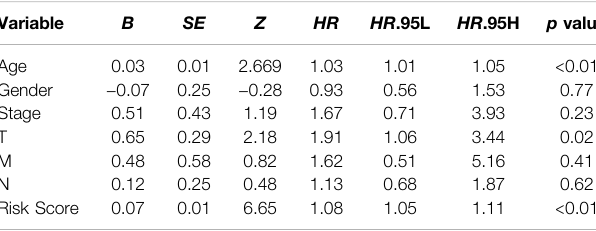
TABLE 2 | Multivariate COX regression analysis ( n =